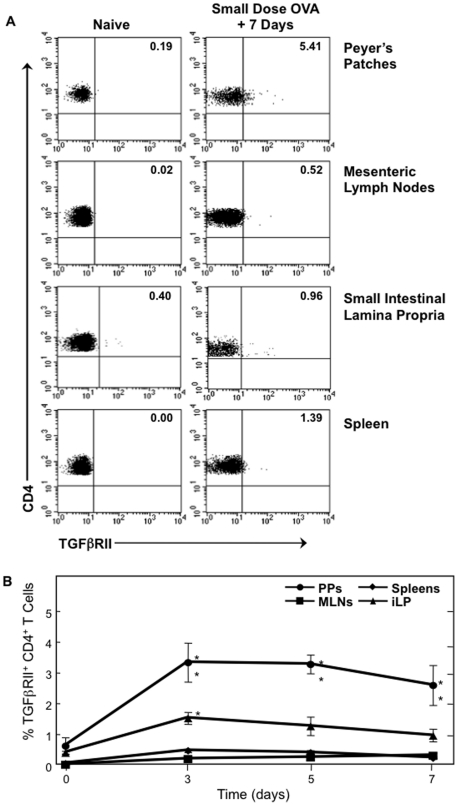
Effect of small-dose OVA feeding on the occurrence of CD4+ TGFβRII+ T cells.Mononuclear cells were isolated from PPs, MLNs, iLP, and spleens of naïve C57BL/6 mice (0) and at time points during ad libitum OVA feeding (1 mg/ml). Cells were then stained with FITC-conjugated anti-hTGFβRII, APC-labeled anti-CD4, and biotin-tagged anti-CD3 mAbs followed by PerCP-Cy™5.5-conjugated streptavidin. Samples were subjected to flow cytometry analysis by FACSCalibur®. A. Plots are representative of naïve tissues and tissues analyzed 7 days after beginning OVA feeding. B, Time course of CD4+ TGFβRII+ T cells frequency in PPs, MLNs, iLP and spleens 3, 5 and 7 days after 30 mg of OVA feeding, n = 10 mice per time point, **p<0.01 when compared to sham-tolerized control group.